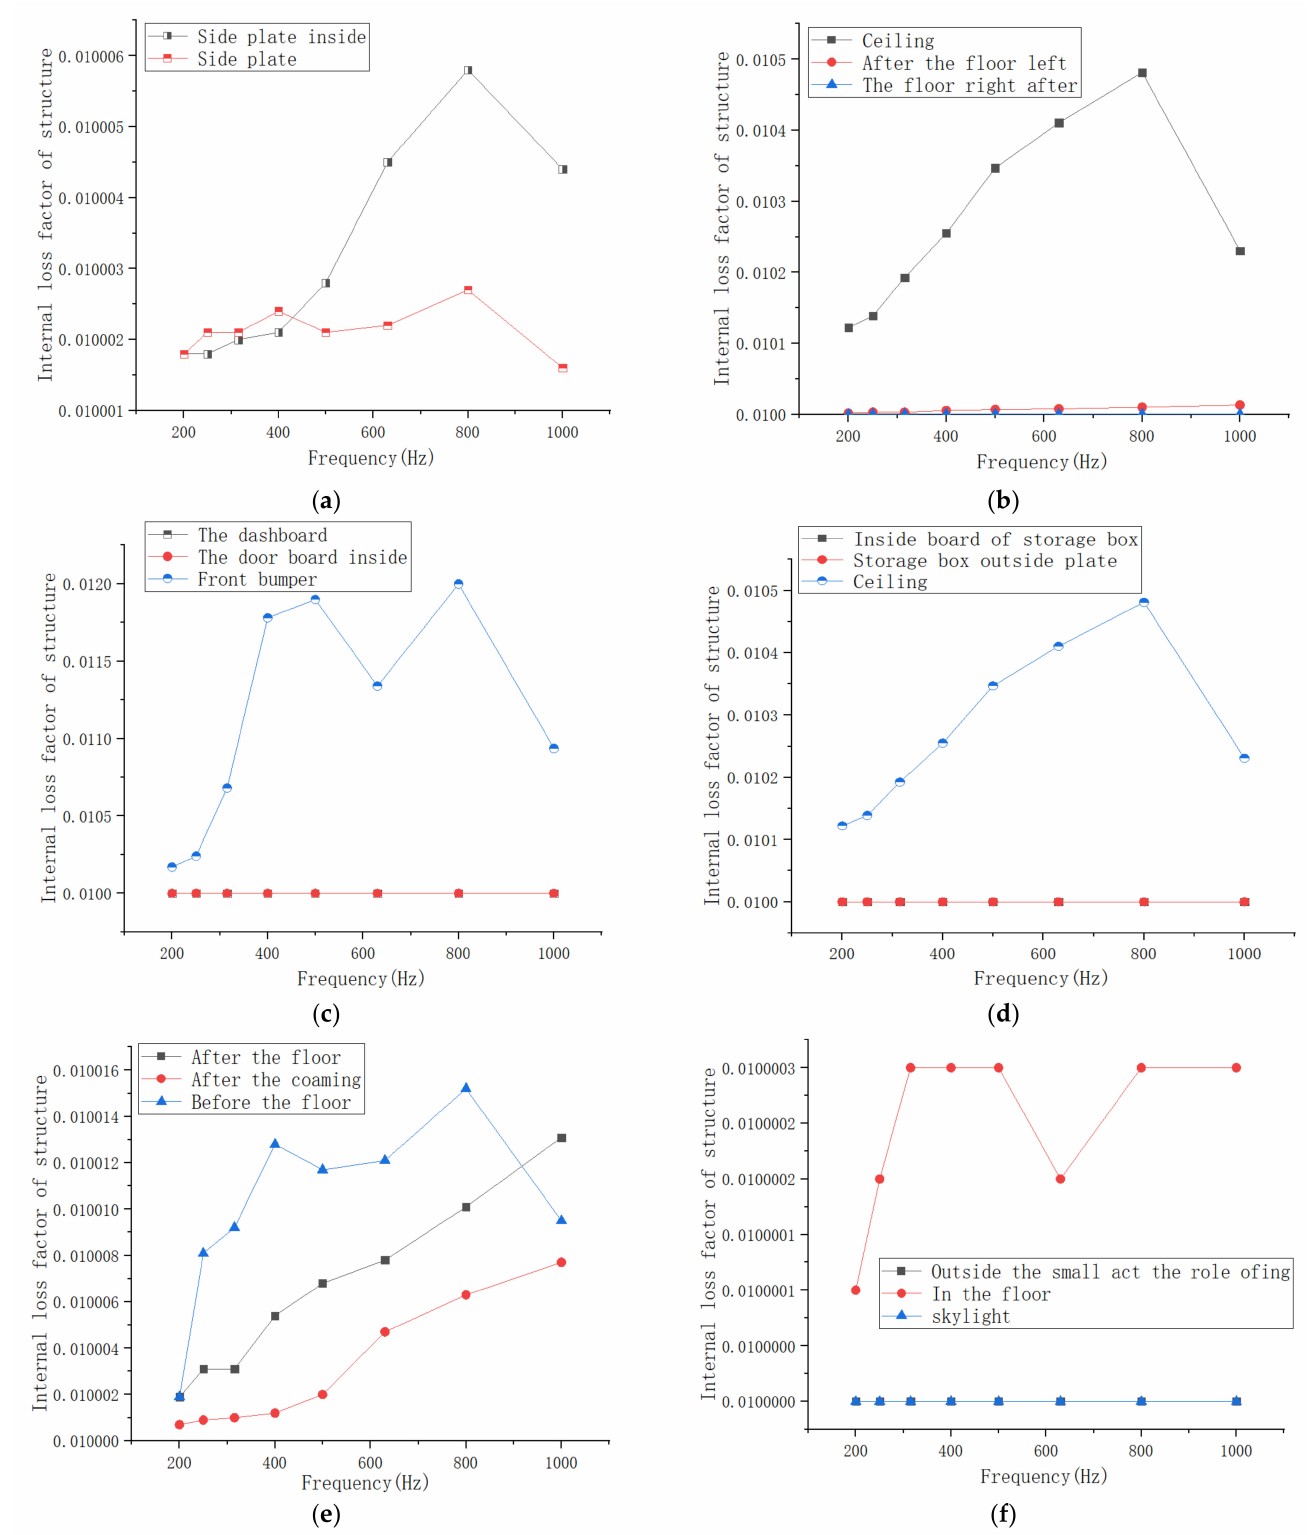
Figure 8. Internal loss factor test results of different structures. ( a ) Internal loss factor of side plate; ( b ) Roof and other structures of the internal loss factor; ( c ) Internal wear factor of bumper and other structures; ( d ) Internal loss factor of storage box and other structures; ( e ) Internal wear factor of rear floor and other structures; ( f ) The internal loss factor of floor and other